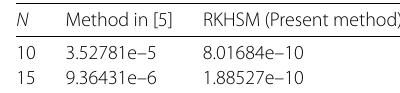
Table 4 Maximum absolute error for Example 4 ( n = 5)